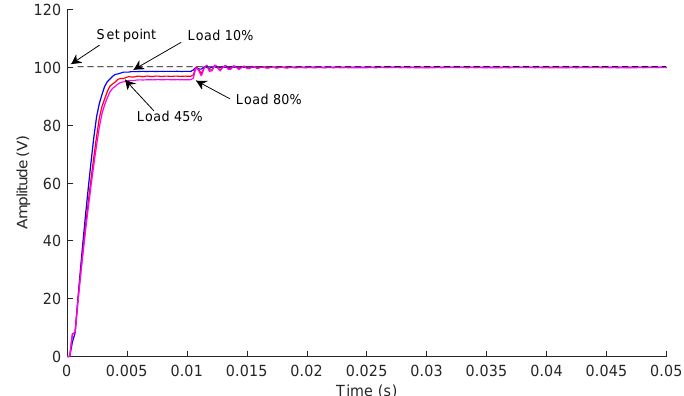
Figure 15. Response of the control to a 100-V set point with different connected load